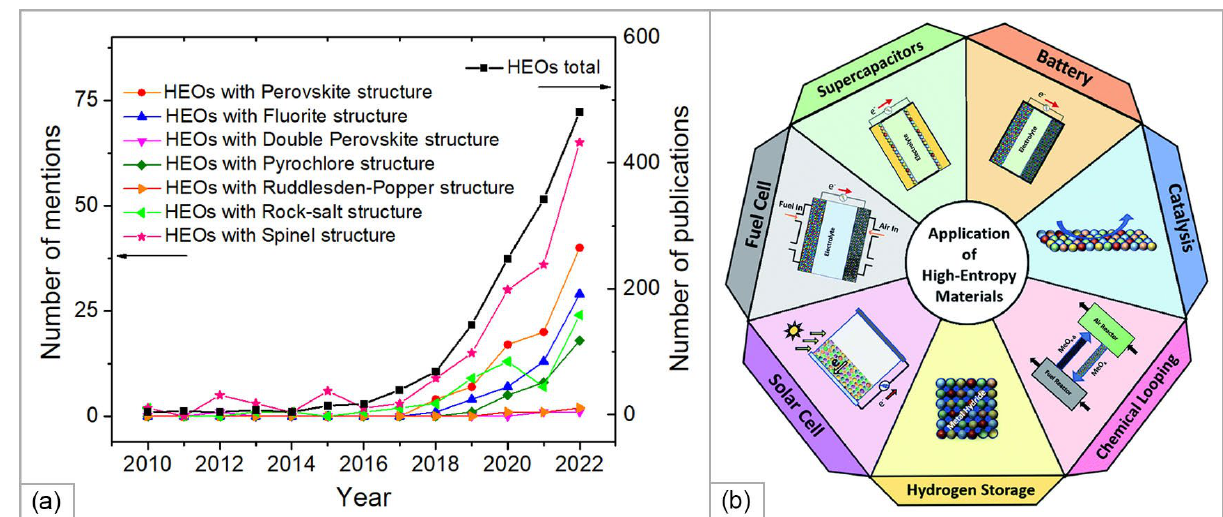
Figure 9. ( a ) Recent publications (on the development and application of high-entropy oxides (HEOs) of different structures (years 2010–2022, according to Scopus data); ( b ) schematic illustration of advanced applications of high-entropy ceramic materials including HEOs (reproduced from [103] with permission of the Royal Chemical Society).